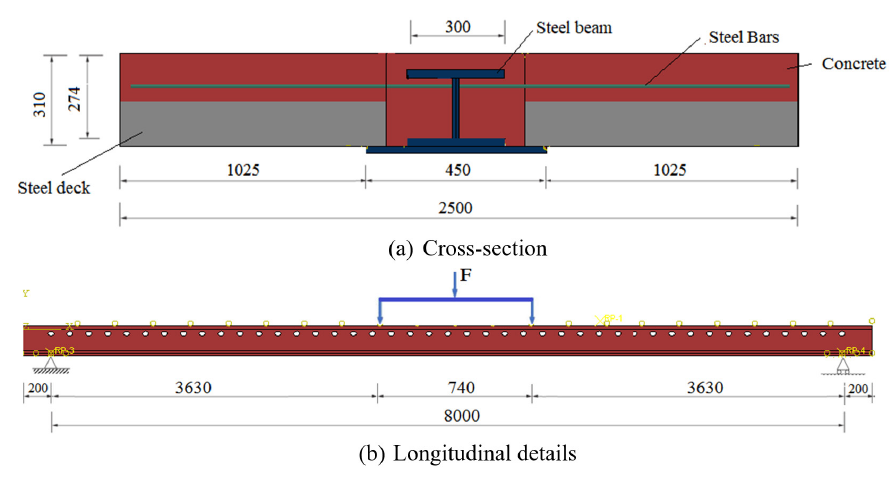
Figure 5. Geometrical characteristics of Hechler et al. [5] test (measurements in mm).